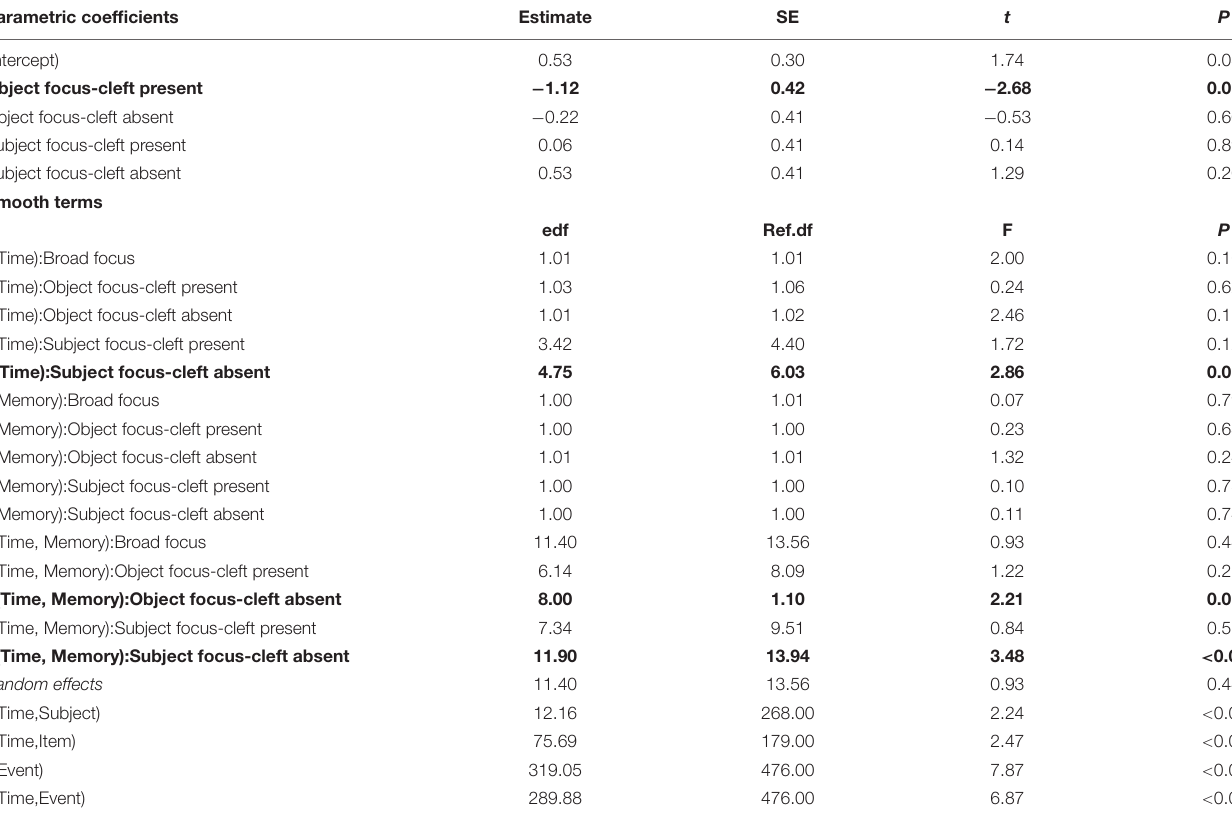
TABLE 4 | Summary statistics of the “Memory” Generalised additive mixed model for 3- to 6-year-olds. Parametric coefficients